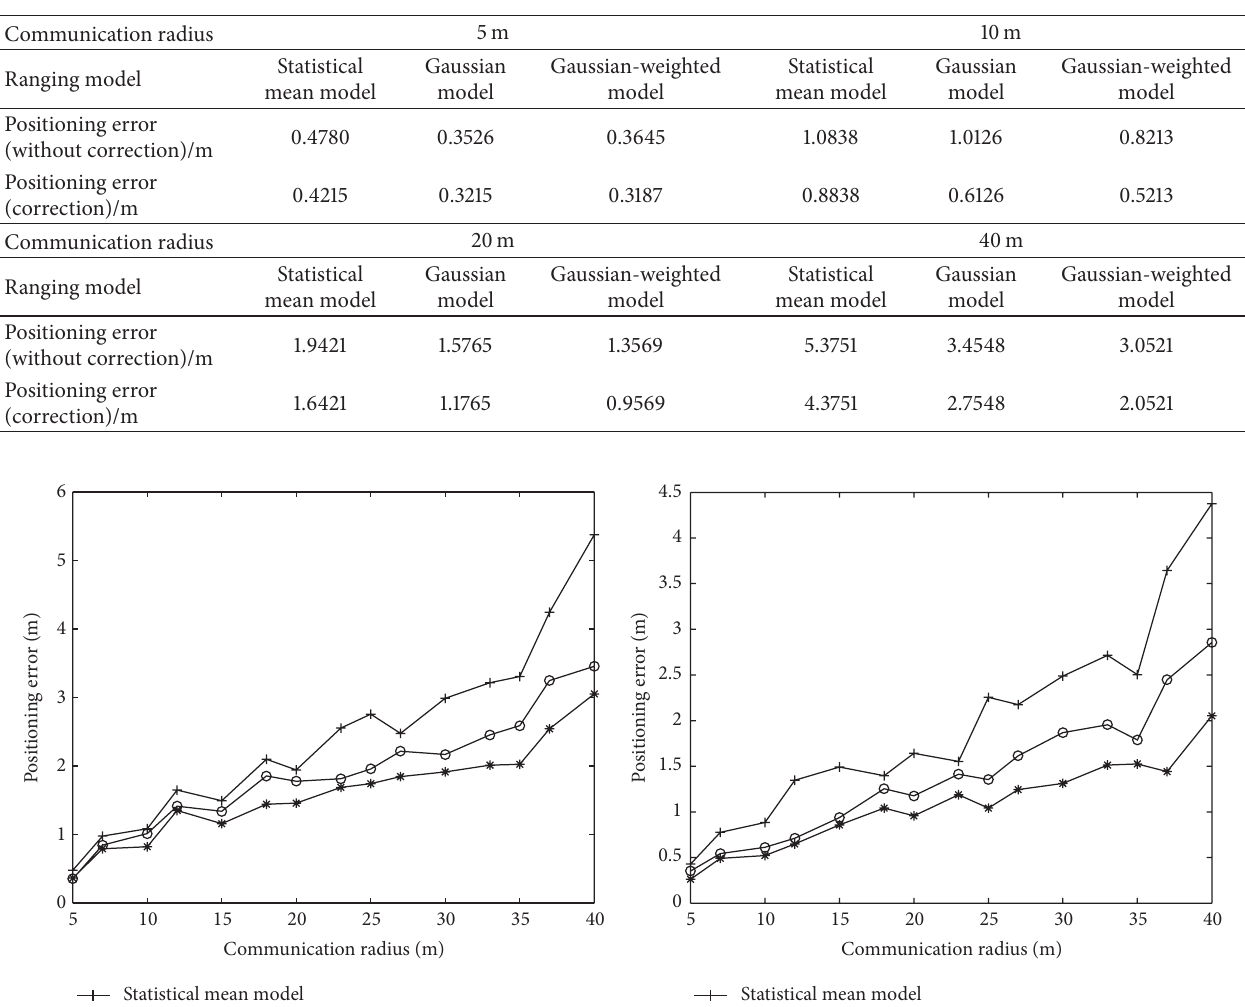
Table 2: Comparison of the positioning error.